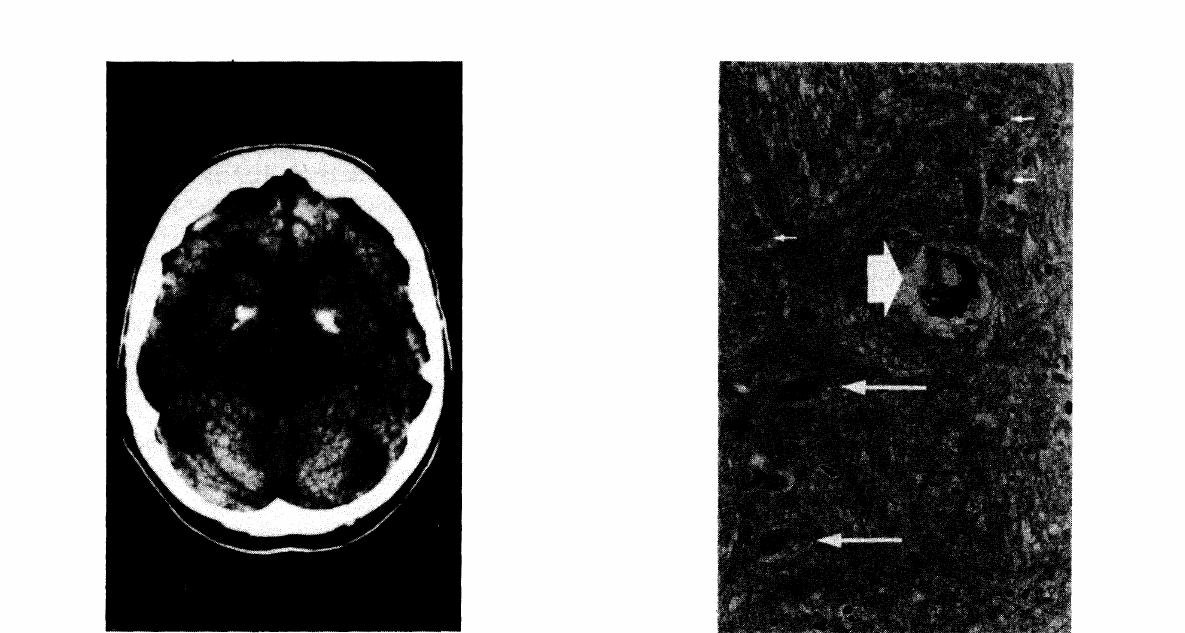
FIG. 1. Bilateral basal ganglia mineralization and cortical atrophy in an 80 year-old patient with dementia and long-lasting depressive symptoms (patient C). ironing her clothes. She remained much the same until 12 years later when she went to the police to accuse her neigh